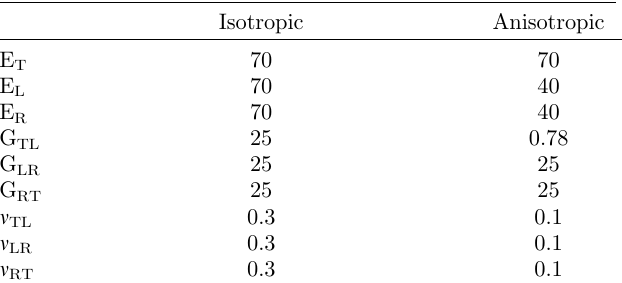
Table 3. Material properties used for the computation of the modal basis of Coil55: E is the Young modulus in GPa, G is the shear modulus in GPa and m is the Poisson ’ s ratio. Orientations are given by T (tangential = direction along the strands), L (longitudinal = coil axis) and R (radial).